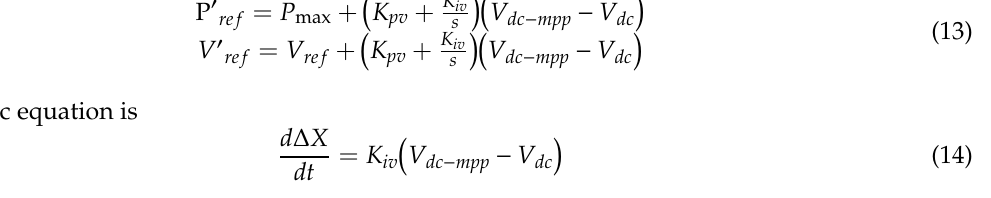
Figure 3. Output control considering photovoltaic output characteristics. Legend: V dc − mpp the maximum power point P max , the corresponding output power of the maximum power point.